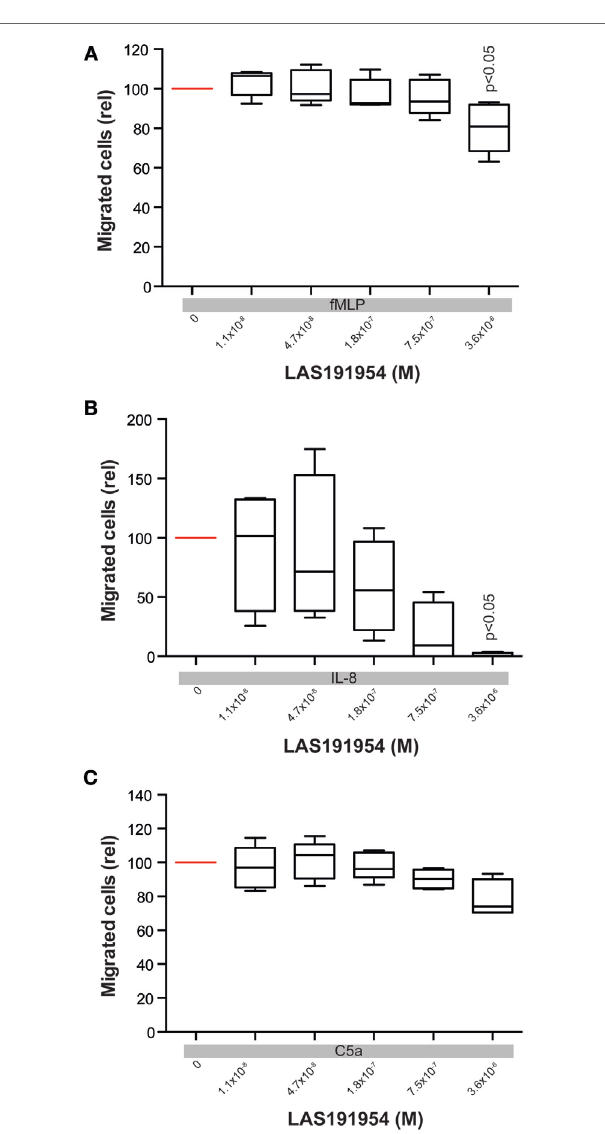
FigUre 5 | Blockade of PI3K δ mainly blocks IL-8 induced polymorph nuclear cells (PMN) migration. Migration of human PMN was induced using (a) fMLP, (B) IL-8, or (c) C5a in the presence of LAS191954. All panels show migrated cells in relation to the positive control (vehicle, no LAS191954). Data are based on five experiments per group, with the exception of C5a-induced migration ( n = 4). For all panels, one-way ANOVA with Holm-Sidak posttest was used for statistical analysis.